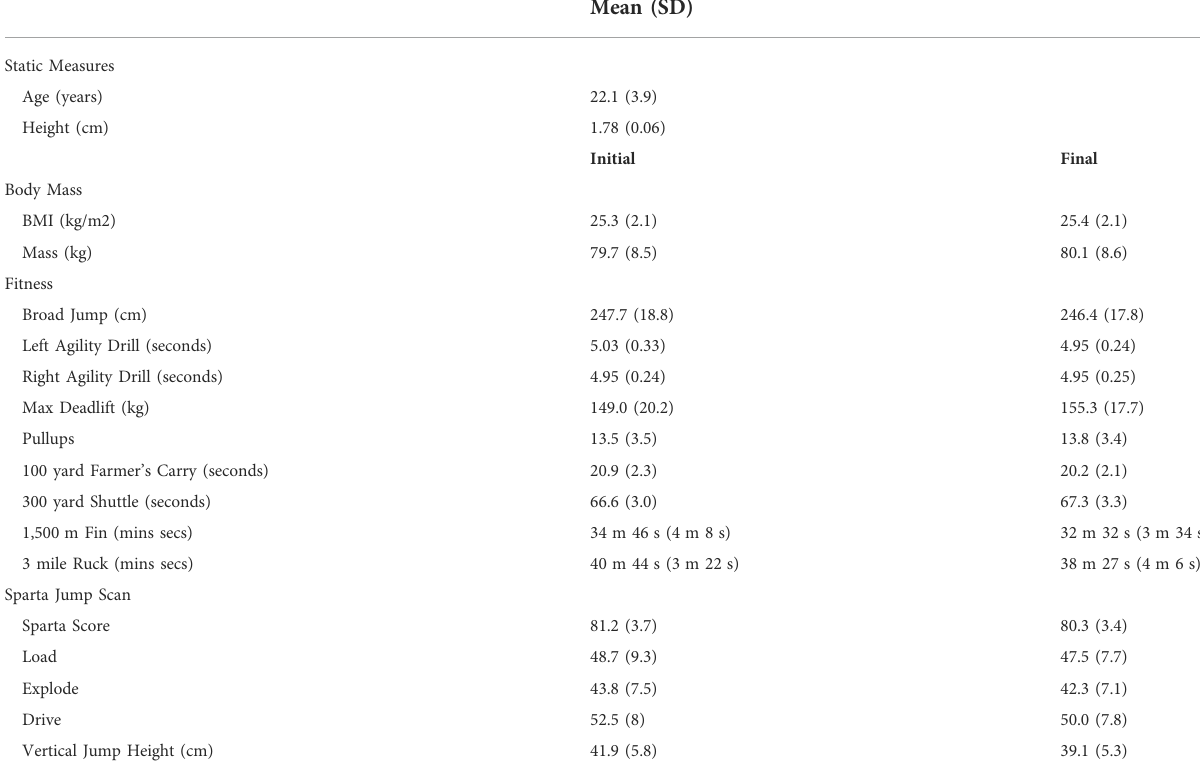
TABLE 1 Baseline demographic information, fi tness, and Sparta TM values for Air Force Special Warfare (SW) trainees entering and exiting the SW PreparatoryCourse(n=643).InitialmeasurementsarecollecteduponentryoftheSWPreparatoryCourse,andFinalmeasurementsarecollected upon exit from the SW Preparatory